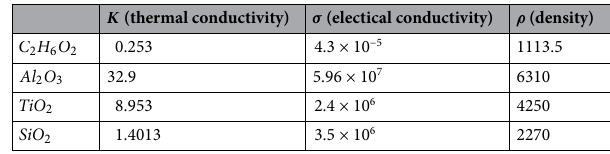
Table 1. Thermal properties related nanoparticles in EG 21,27 .